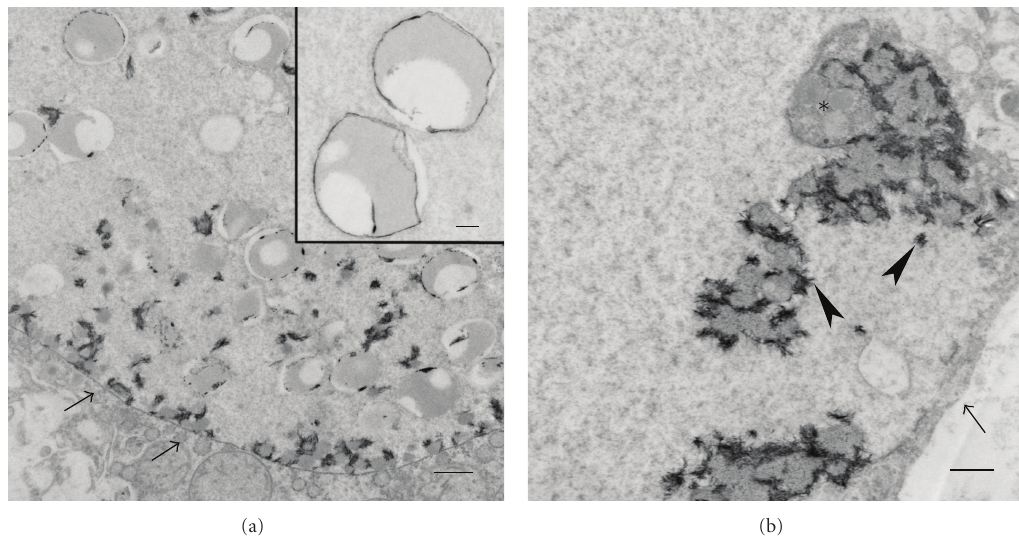
Figure 3: Liver: (a) cytoplasmic crystalline inclusions within a hepatocellular vacuole (arrows). Bar: 2 µ m; Inset: higher magnification of inclusions. Bar: 500nm. (b) the hepatocellular vacuole (arrow) containing intermediate electron-dense lipid ( ∗ ) with highly electron-dense mineral (arrowheads). Bar: 1 µ m. Uranyl acetate-lead citrate stain. Transmission electron